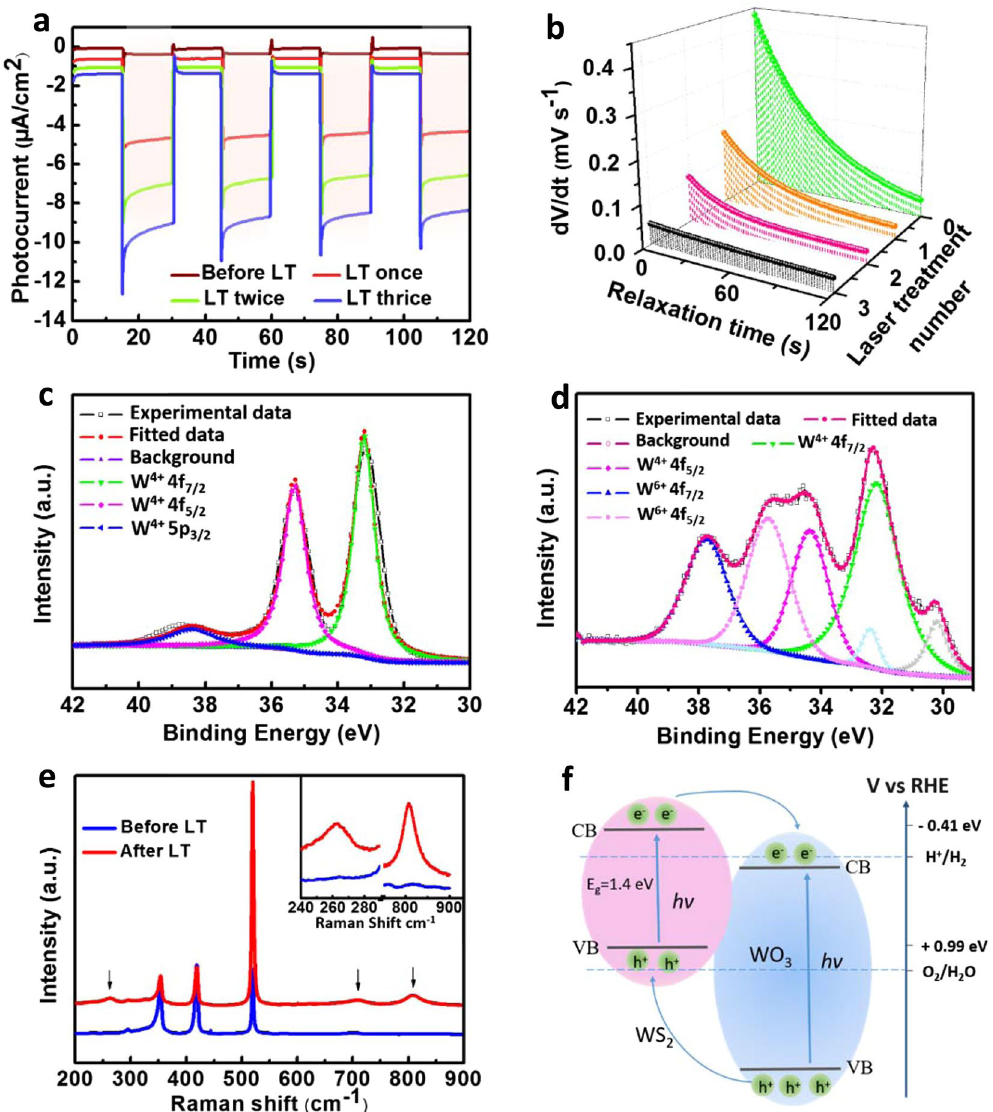
Figure 4. ( a ) Photocurrent as a function of time under solar simulated illumination (420 nm cut-off) without bias of the corresponding WS 2 before and after one, two, and three laser treatments. ( b ) Electron lifetime measurements obtained based on decay of open circuit potential in a dark environment. XPS spectra of W 4f core level peak region for WS 2 ( c ) before and ( d ) after laser treatment. ( e ) Raman spectra of WS 2 before and after laser treatment. Inset shows two magnified peaks from 240 to 290 cm − 1 , and 750 to 900 cm − 1 . ( f ) Schematic diagram of band structure and charge transfer in WS 2 /WO 3 heterostructure under visible light irradiation. (LT represents to laser